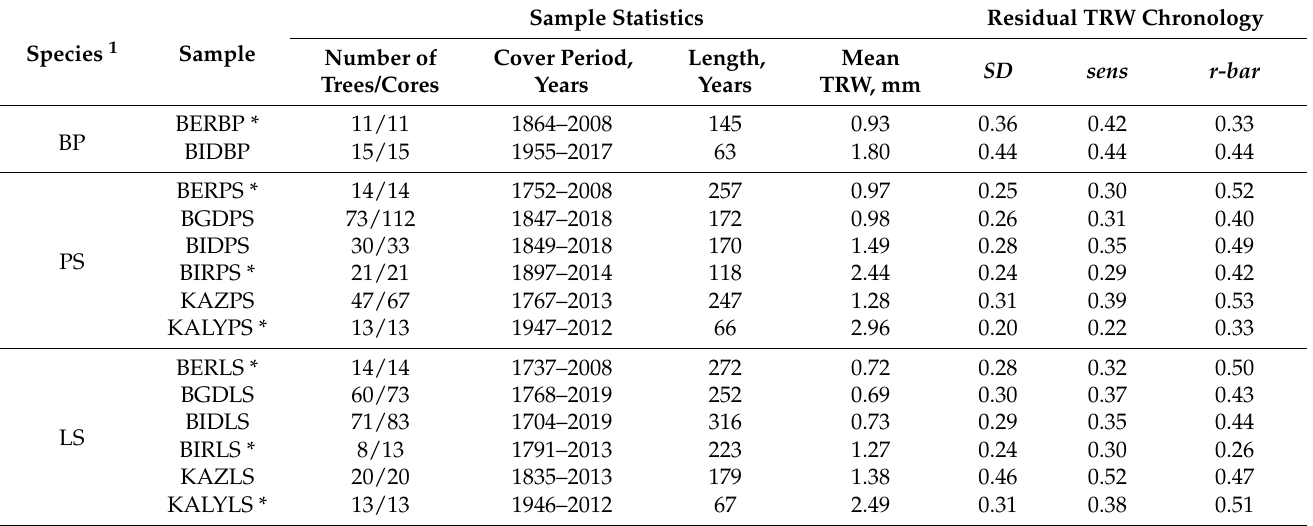
Table 2. Statistical characteristics of tree-ring width (TRW) samples and indexed (residual)